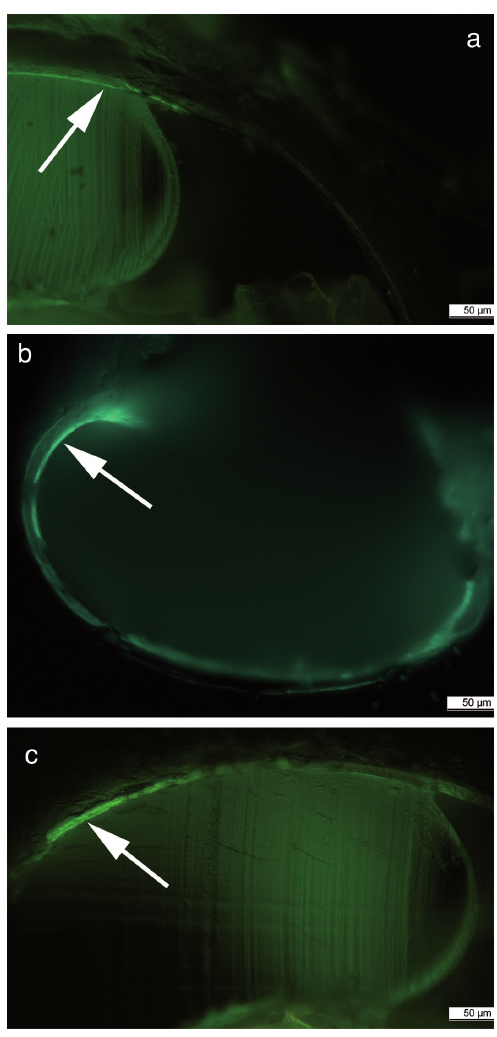
Fig. 11. Cross sections of Limacina helicina shells in the region of shell increment. (a) Dorso-lateral section (higher magnification of the right part of (c) showing a fluorescence band at the inner shell surface, arrow pointing at the thin inner fluorescence line). (b) Cross section of the aperture region distal from the area of in- crement, the arrow pointing at the line of constructive processes at the inner prismatic shell layer. (c) Dorso-lateral section showing calcein incorporation in all shell layers (prismatic, middle crossed- lamellar, inner prismatic) close to the aperture